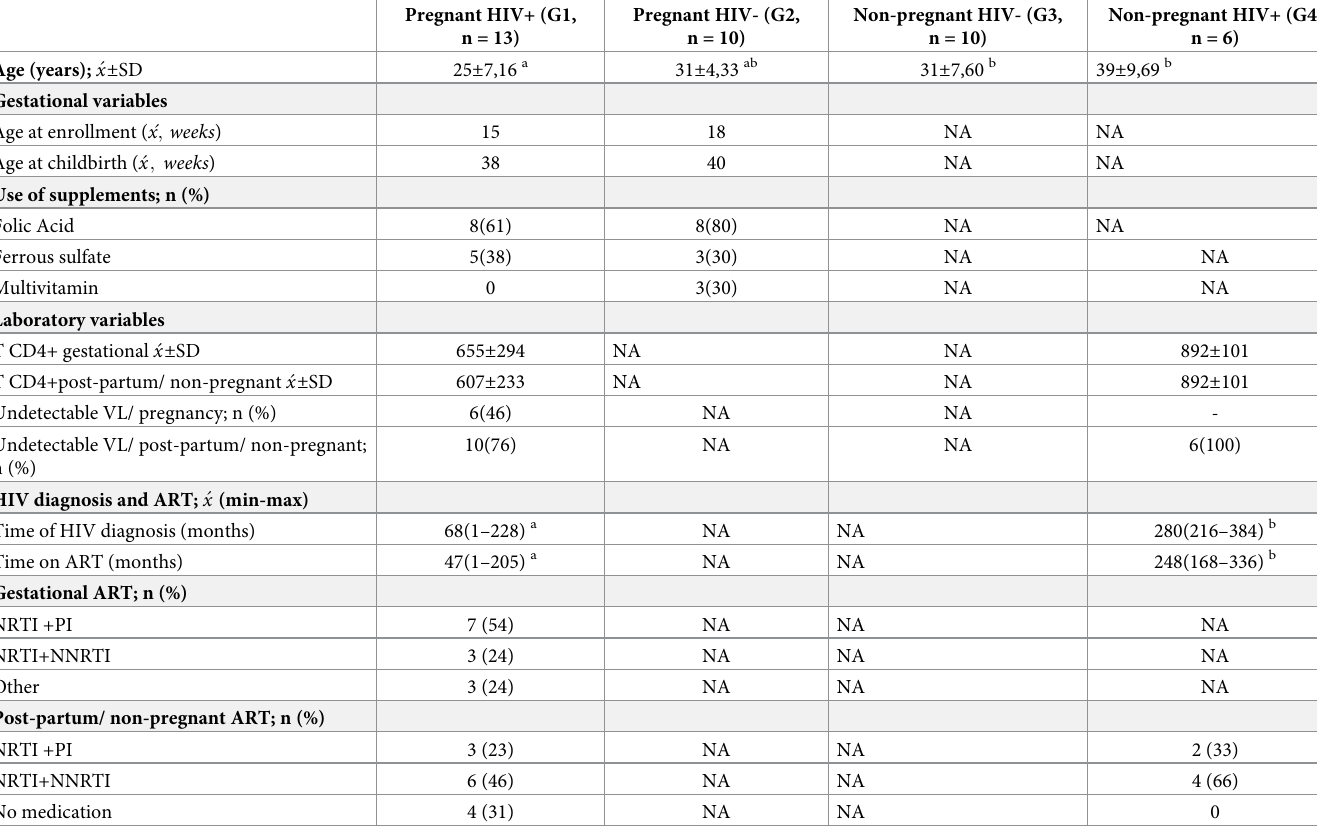
Table 1. Sociodemographic and clinical data of patients included.